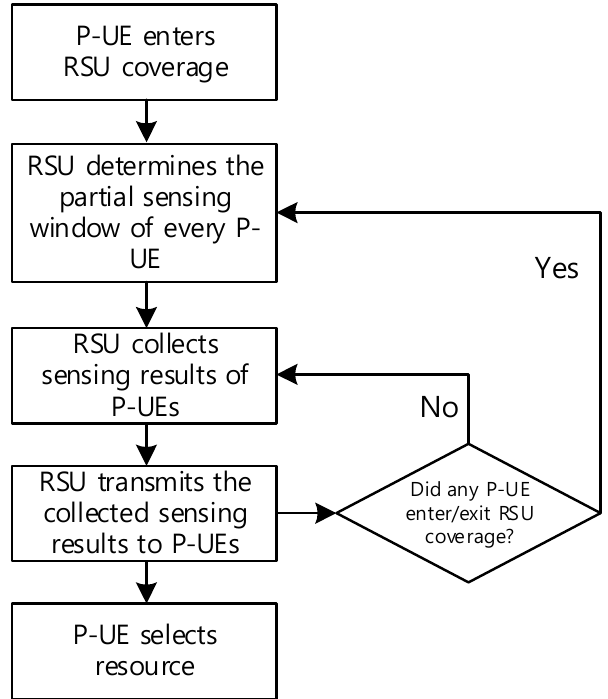
Figure 4. Proposed method of combining all the partial sensing results using the RSU.